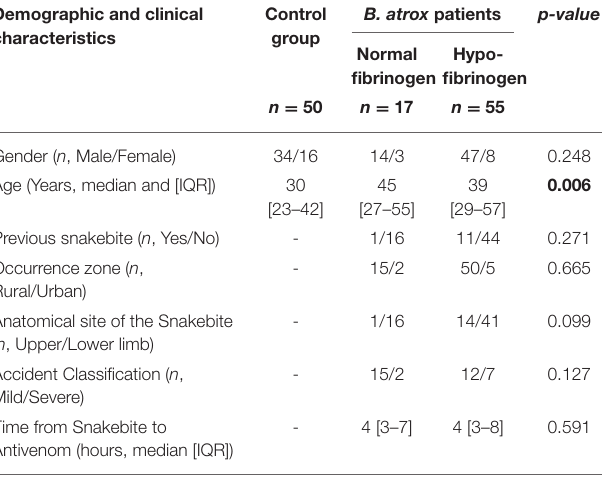
TABLE 1 | Demographic and clinical characteristics of patients and individuals included in the study. Demographic and clinical